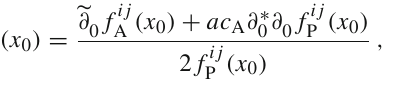
by an asterisk is only used for the determination of the PCAC masses. The lattice spacings a are obtained by interpolating the results of Ref. [22] with a polynomial fit. All configurations are separated by 8 MDU’s except for the ensembles A1k3 (4 MDU’s) and D1k4 (16